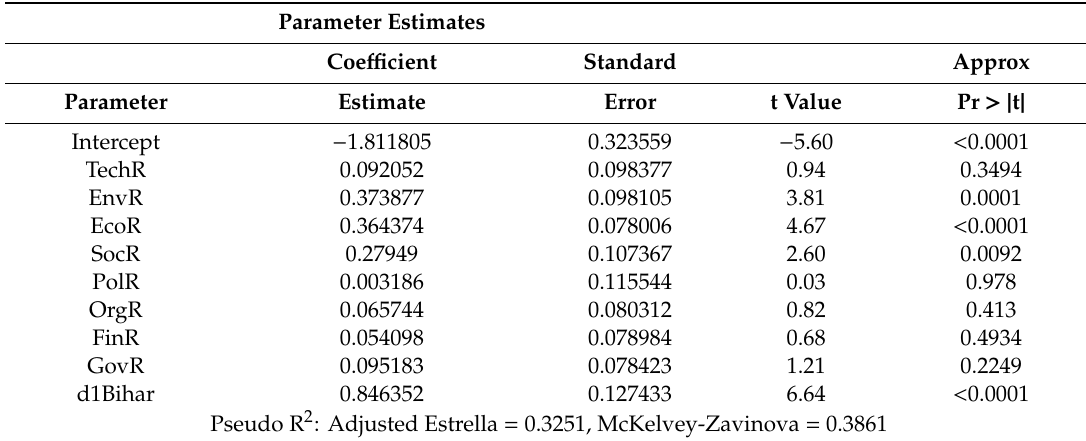
Table 14. Ordered probit regression results—rationalities and environmental performance. Parameter Estimates